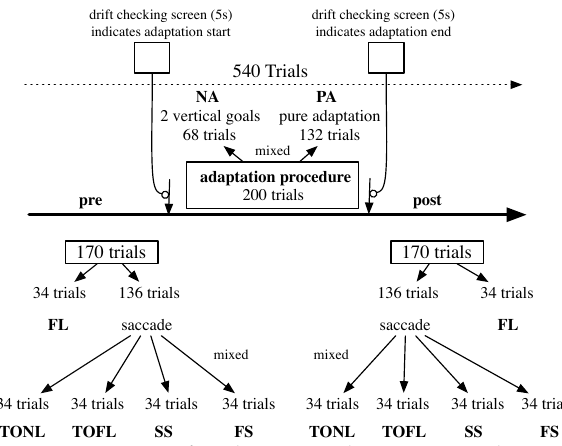
Figure 2 . Course of trials in a single experimental session.